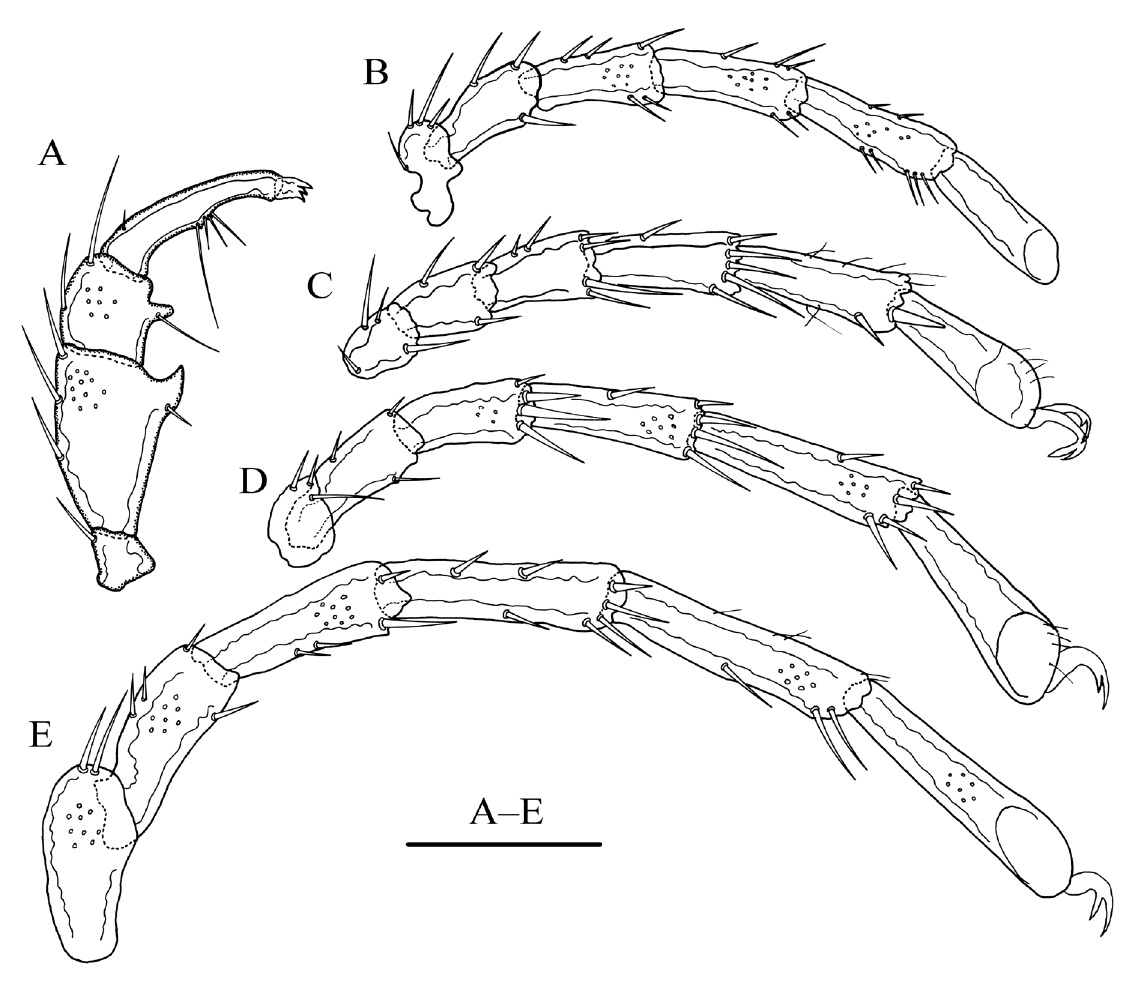
Fig. 6. Torrenticola spinextension Gu & Guo sp. nov., ♂ , holotype (FJ-TO-20180804). A . Palp, lateral view. B . leg-I. C . leg-II. D . leg-III. E . leg-IV. Scale bar = 100